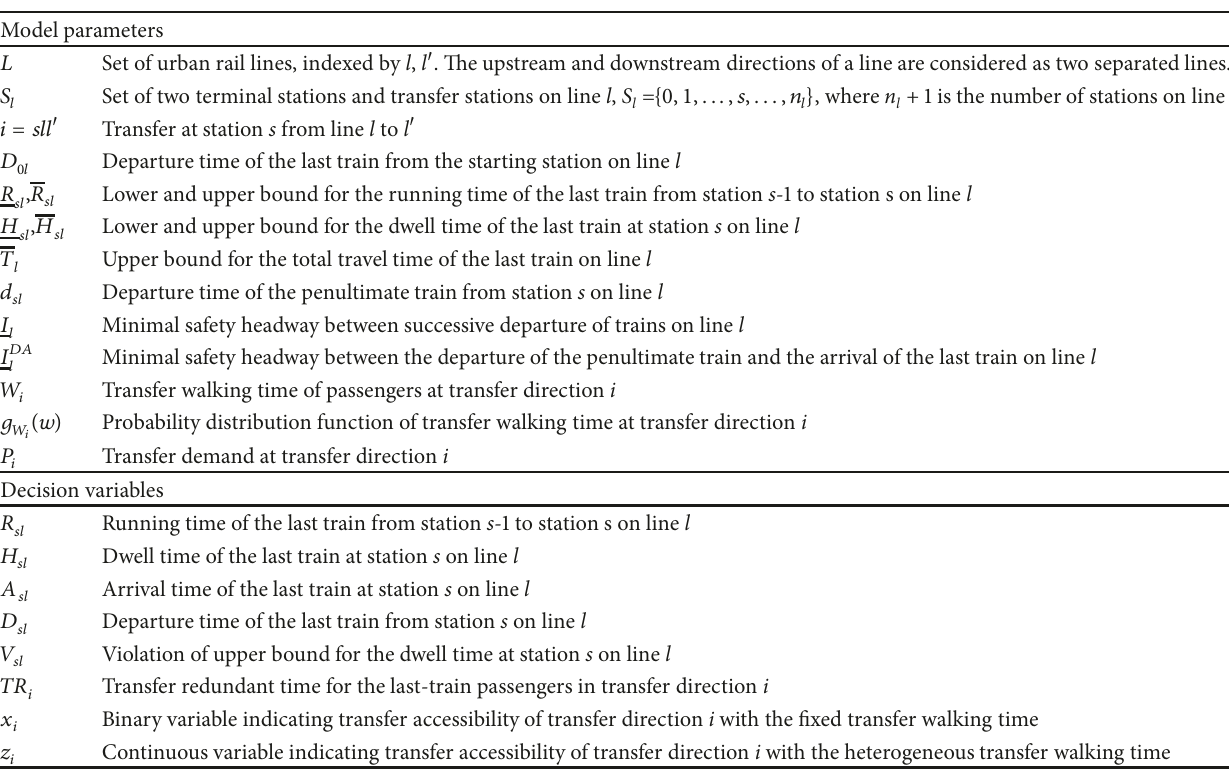
Table 1: Notations and